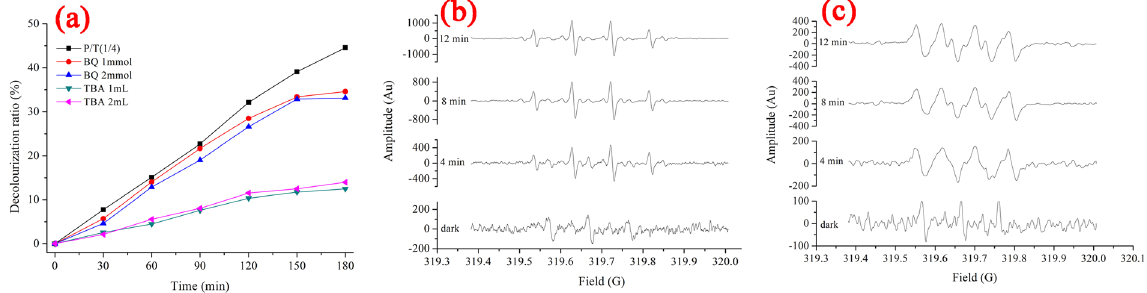
Figure 11. ( a ) Radical trapping experiments on photocatalytic degradation of MB with P/T(1/4) and ESR measurements of ( b ) ·OH and ( c ) ·O 2 − .